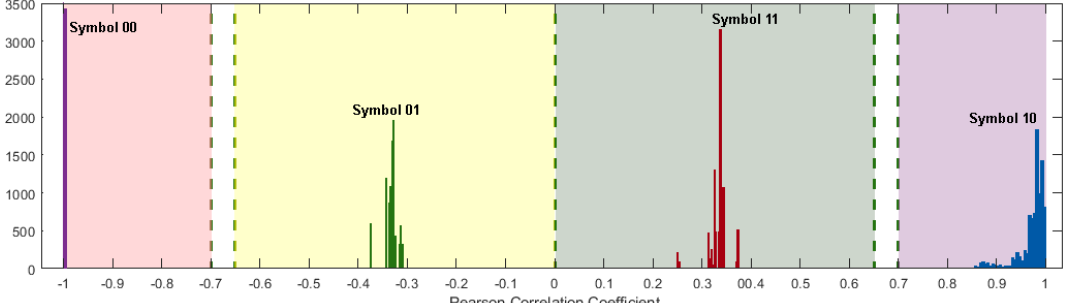
Figure 12. Pearson Correlation Coefficient vs. switching